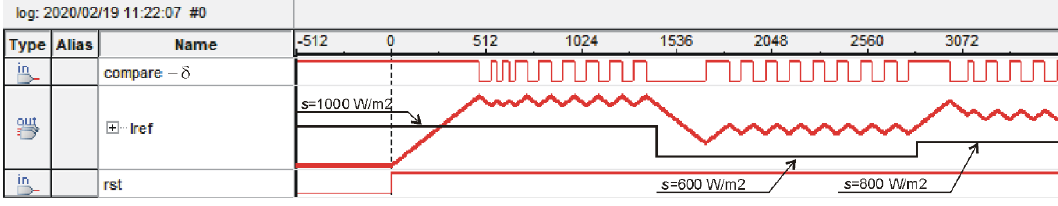
Figure 6. Internal control signals of FPGAs for the proposed MPPT method registered under solar irradiance s steps at temperature 297 in K: δ is the comparison result, I ref is a digital current reference.